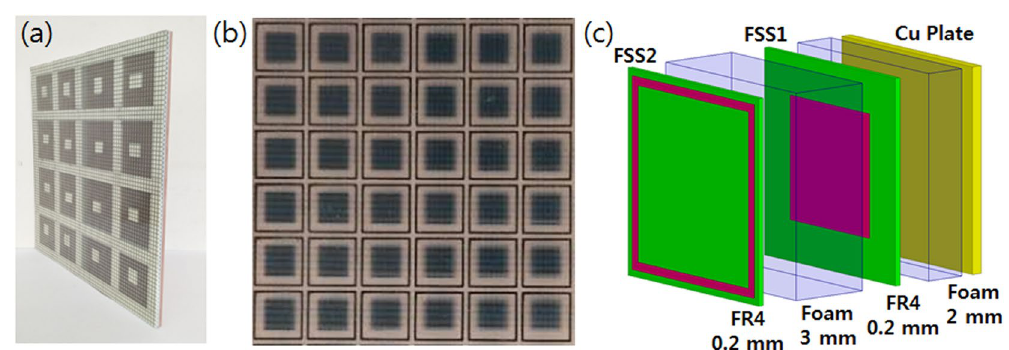
Figure 8. The test sample of a double-layer FSS absorber (size = 50 cm × 50 cm) for the measurement of reflection loss: ( a ) side view, ( b ) top view of printed FSS2/FSS1 patterns with a unit cell periodicity of 7.5 mm, and ( c ) a schematic layer